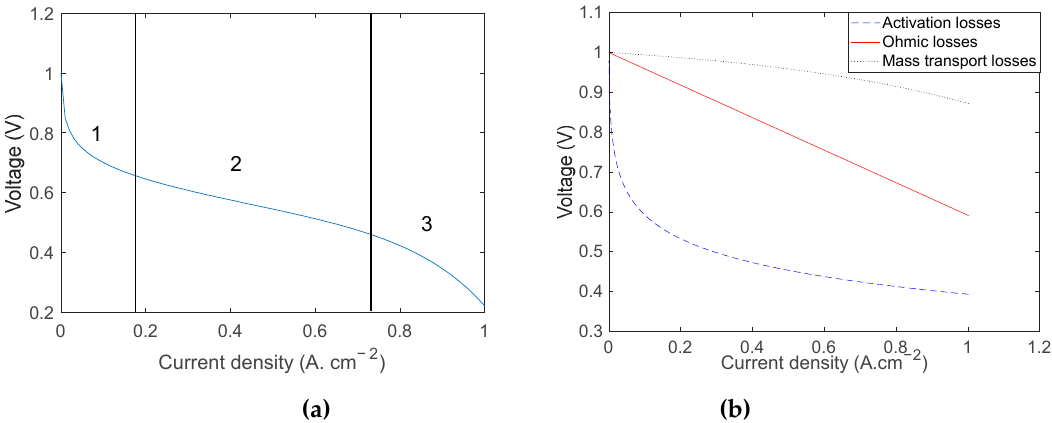
Figure 4. ( a ) A typical PEMFC V-I curve (1: activation loss; 2: Ohmic loss; 3: mass transport loss); ( b ) three di ff erent losses’ functions. Table 3. Mean fitting accuracy of three terms in V-I curve using di ff erent